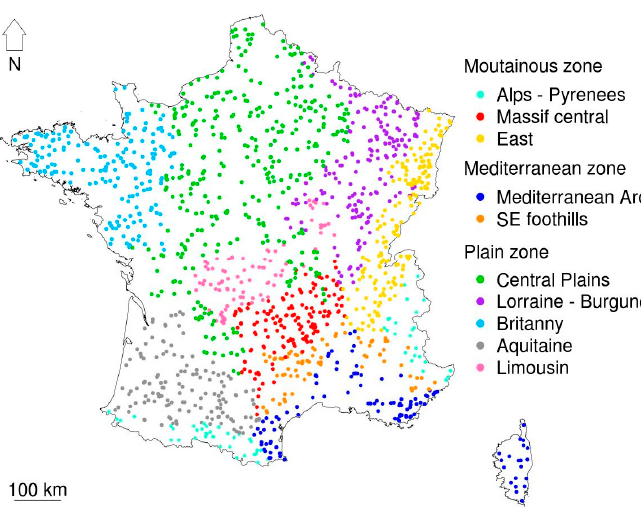
Figure 1. Location of the catchment outlets and sub-regions.